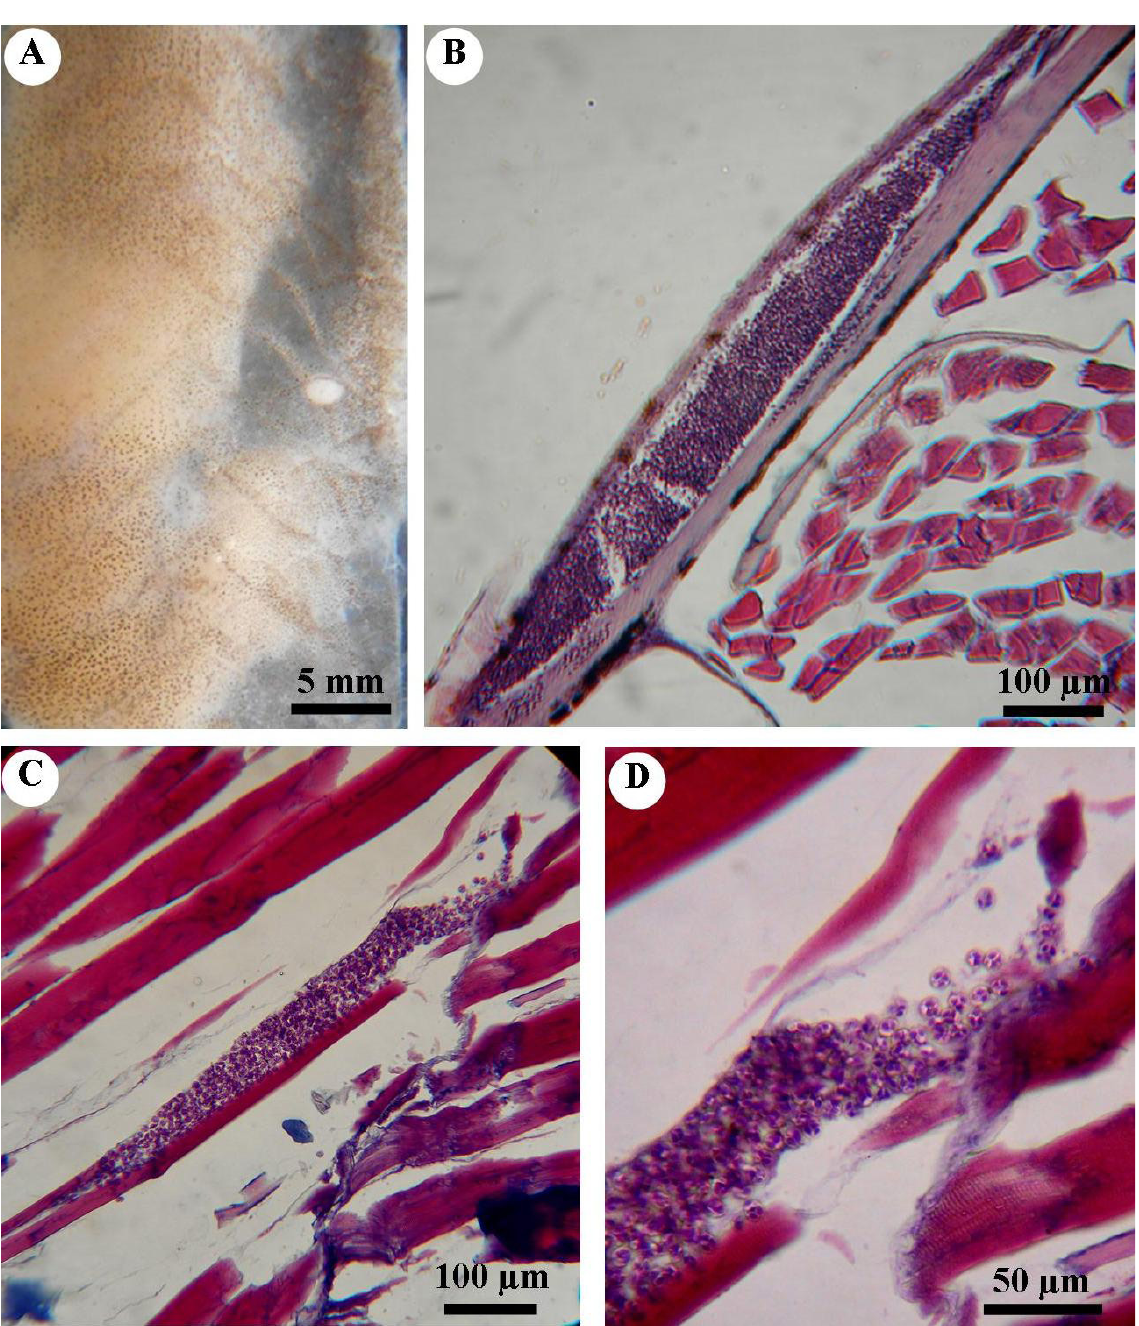
Fig. 2. Photomicrographs of plasmodia of Myxobolus opsaridiumi sp. nov. developing on Opsaridium ubangiensis (Pellegrin, 1901). A . Plasmodium development on the skin. B . Histological section stained with hematoxylin and eosin showing plasmodium situated in the dermis. C . Plasmodium developing within muscle fibers (hematoxylin and eosin). D . Higher magnification of a plasmodium from the muscle